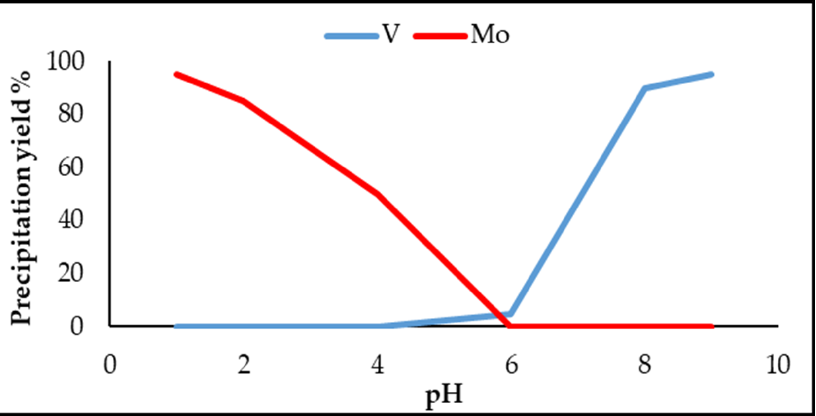
Figure 6. Precipitation yield of molybdenum and vanadium vs.pH (V: 40 °C, time 60 min; Mo: 90 °C, time 60 min).